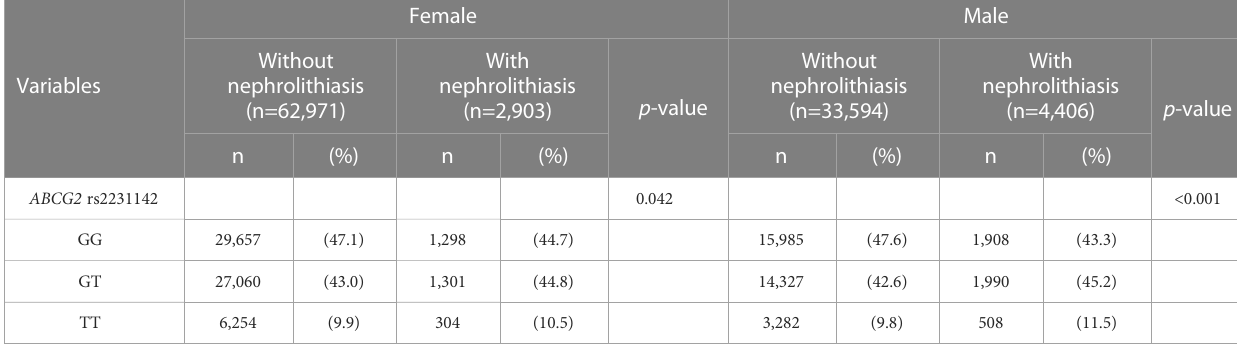
TABLE 2 Sex-strati fi ed risk of nephrolithiasis with the ABCG2 rs2231142 genotypes.